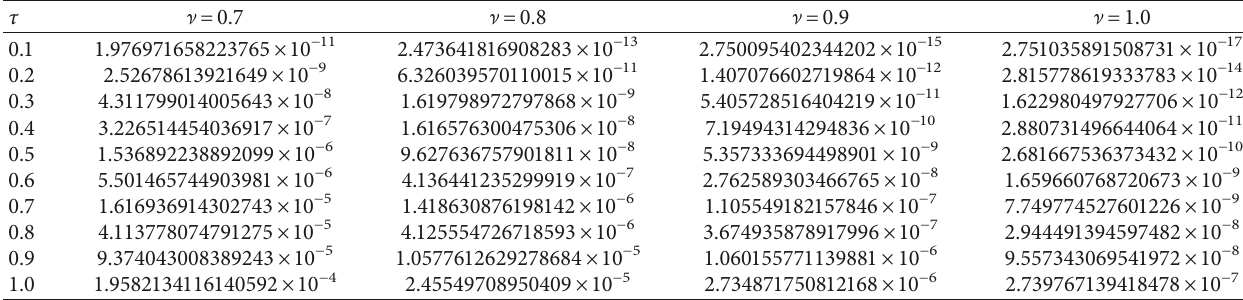
Table 7: The recurrence error of the the approximate solution of the real part in Example 2.